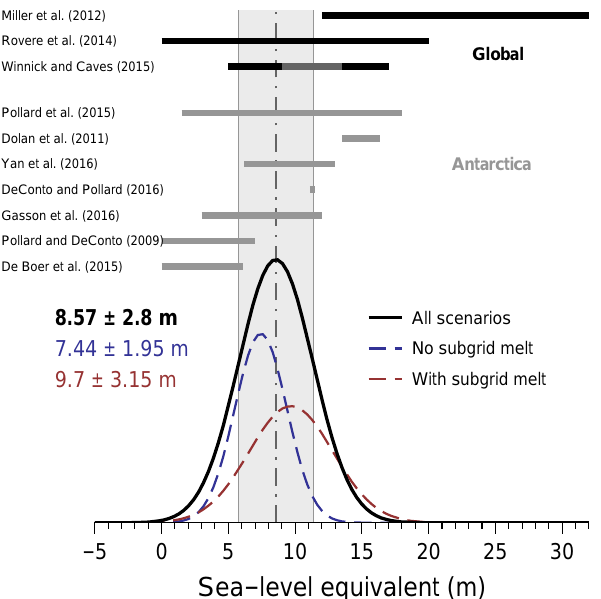
Figure 5. Simulated Antarctic ice-sheet contributions to global mean sea level under a range of RCM-based climatologies, using two different grounding-line parameterizations. Values from previ- ous studies are also shown (grey bars), as well as global sea-level highstand values inferred from far-field